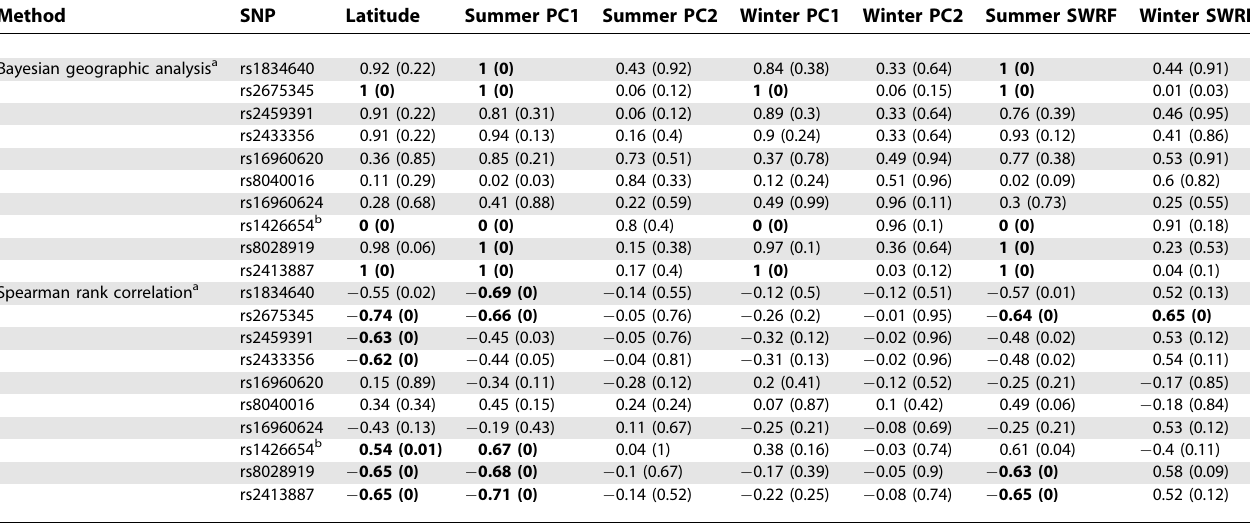
Table 4. Coefficients and p -Values (in Parentheses) for Tag SNPs in SLC24A5